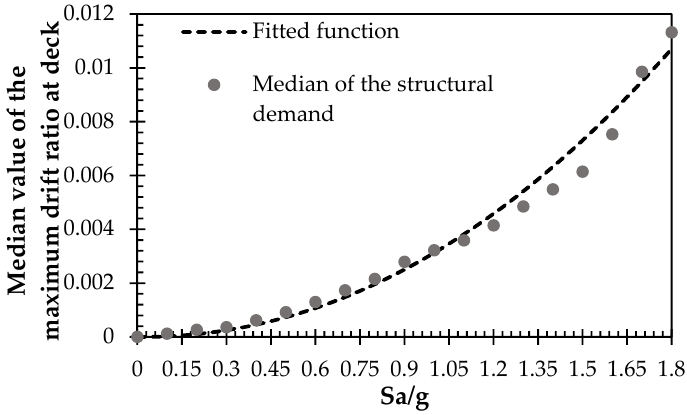
Figure 5. Structural capacity due to earthquakes.